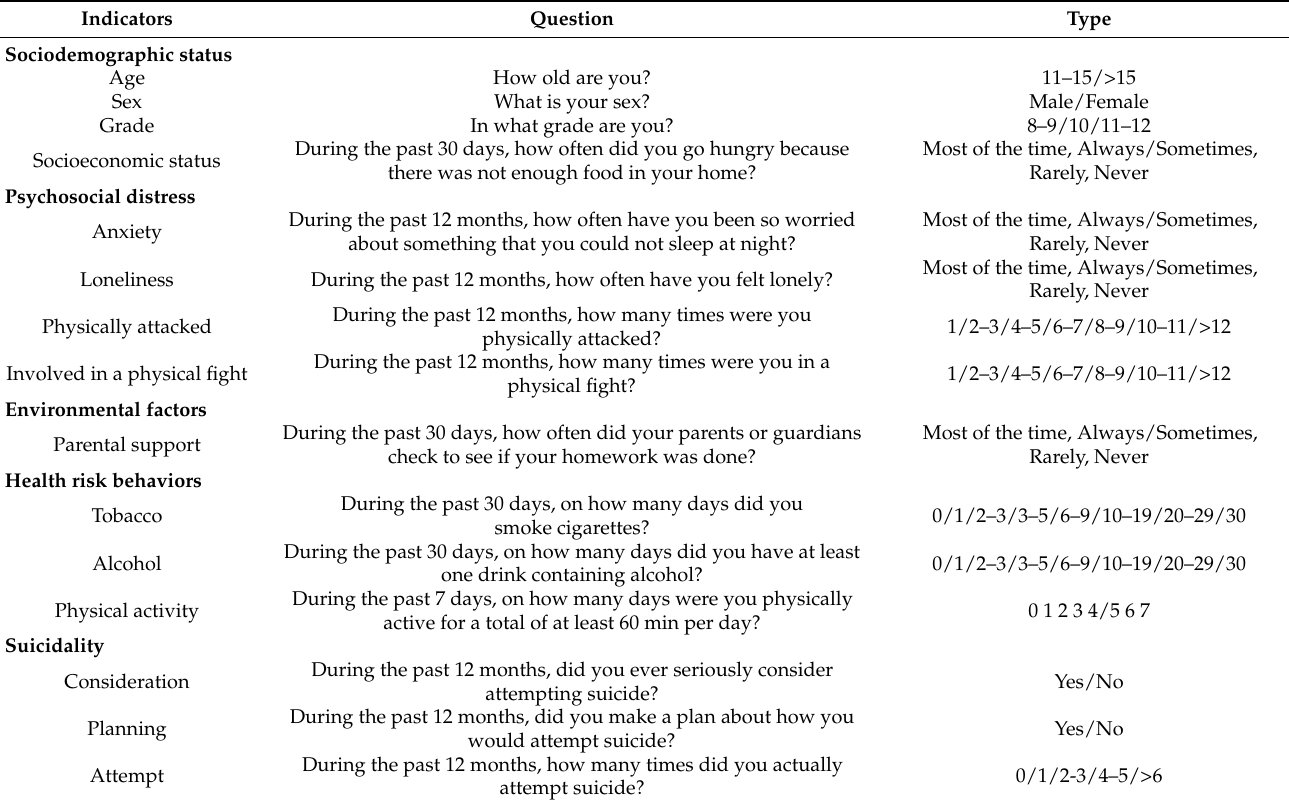
Table A1. Measures used for this